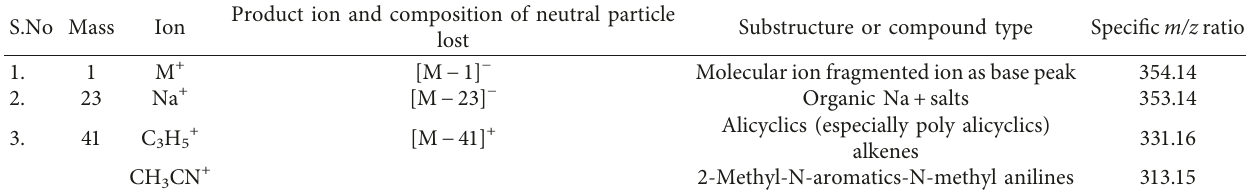
Table 6: Mass spectral interpretation of peak 4 from LC-MS-MS done on A. candolleanus root extract. S.No Mass